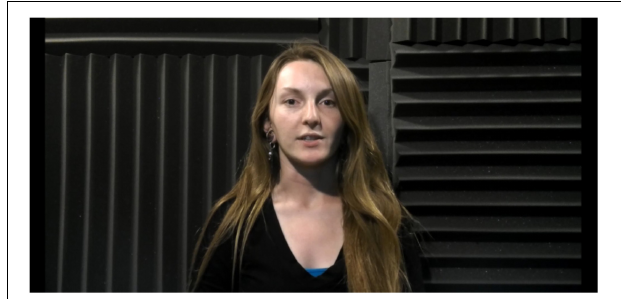
FIGURE 1 | A still image from a multimodal QuickSIN trial consisting of a female